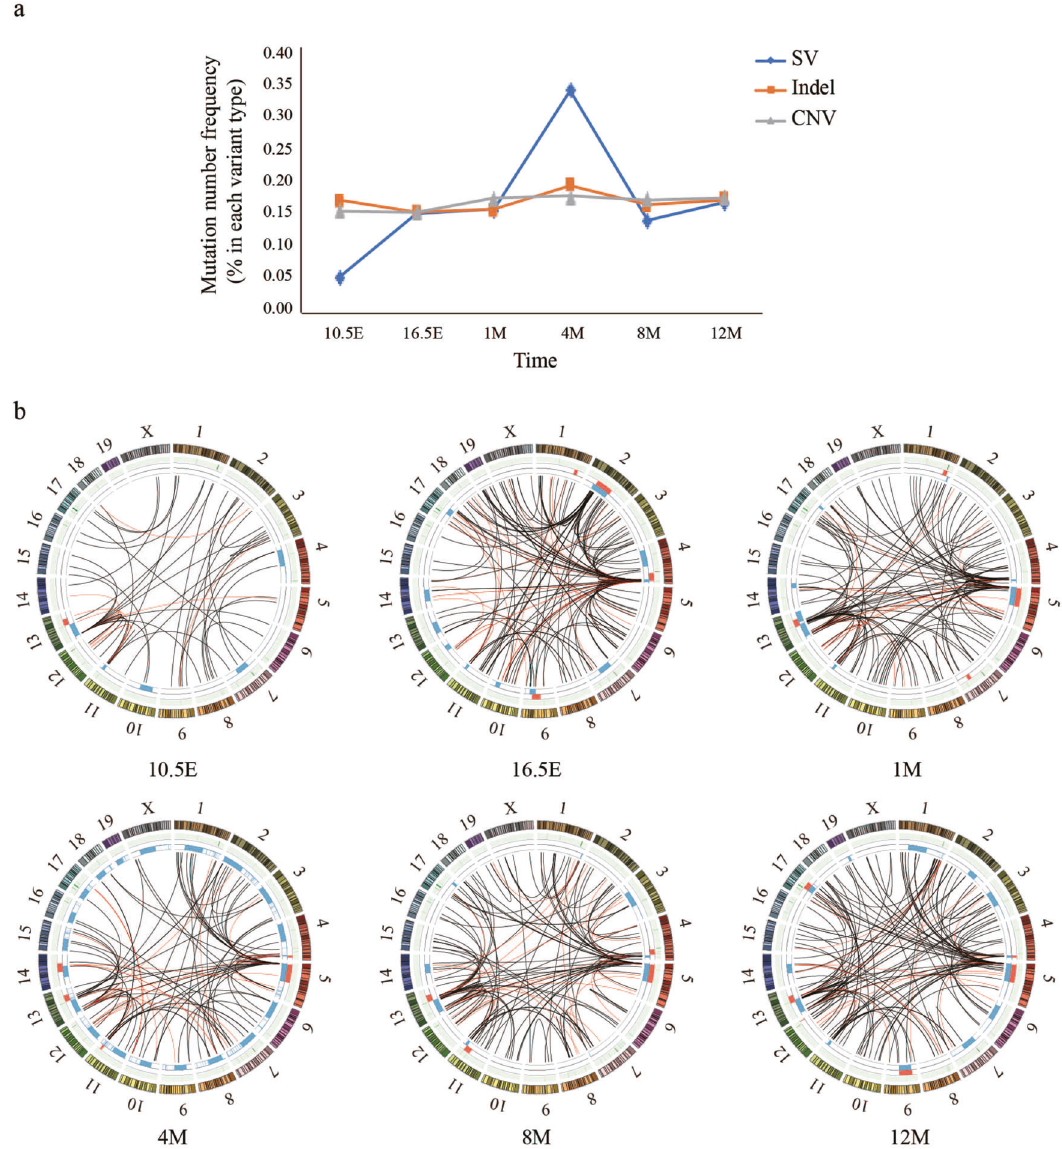
Fig. 1 Monitoring genome instability across developmental stages. Brca1 + / − mice in 10.5E, 16.5E, 1M, 4M, 8M and 12M ( n = 2 in each group) were tested. a SVs, Indels, and CNVs at different time points. Data from 2 mice in each group were combined and divided by 2 to obtain the average value. X -axis: the time points. Y-axis: the mutation frequency normalized by the median. b Representative Circos plots showing the variation at different time points. Outer: indels; middle: CNVs (red: gain; blue: loss); inner: SVs (red: gene affected; black: no gene